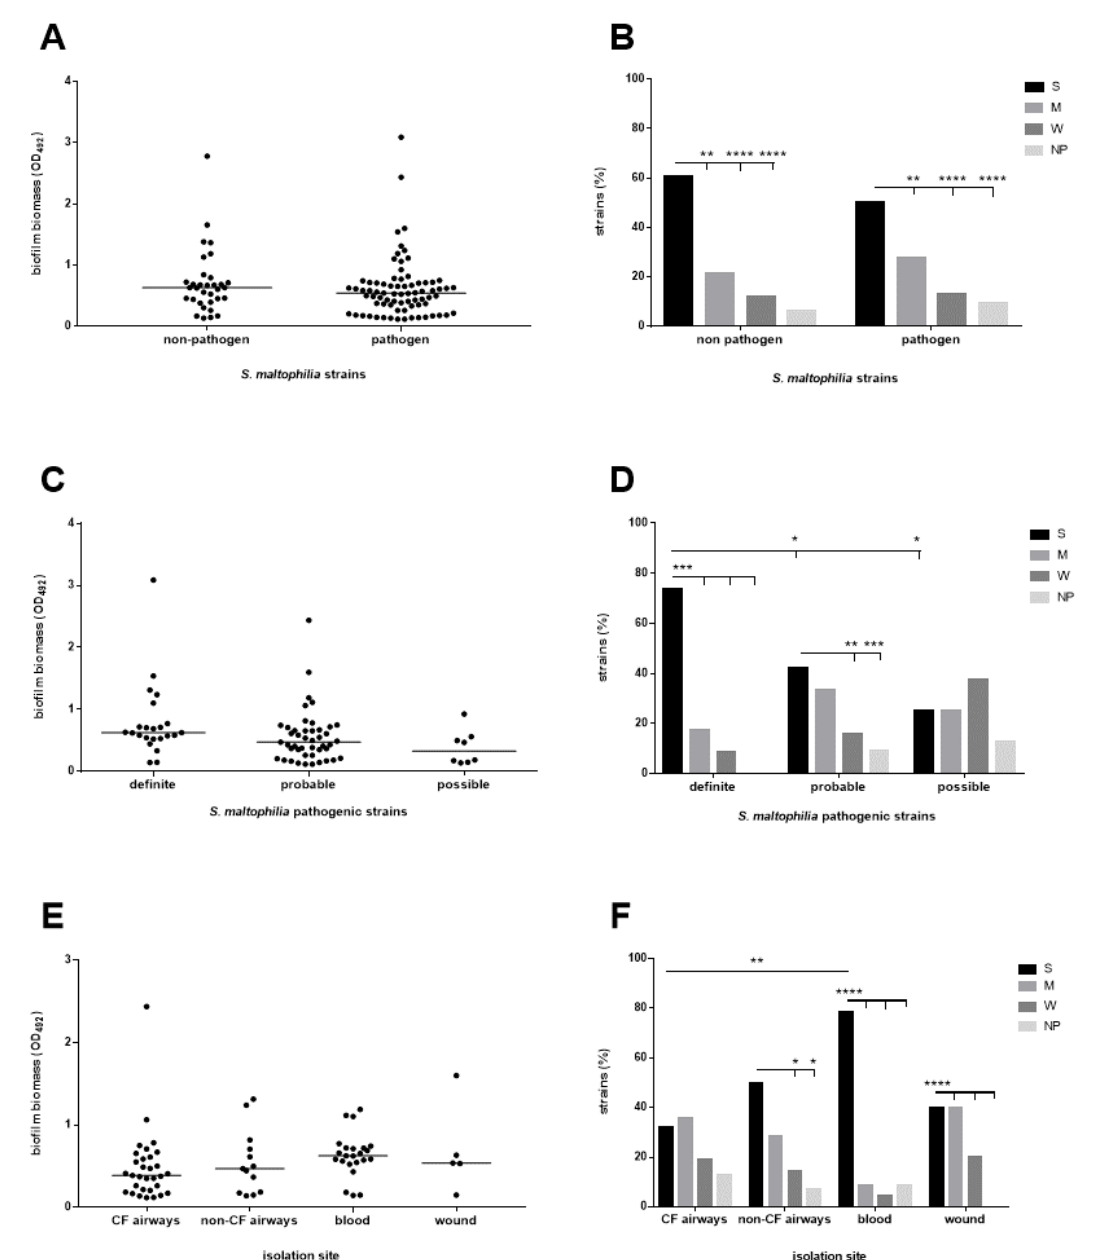
Figure 2. Biofilm formation by S. maltophilia strains and microbiological traits. Biofilm biomass formation was evaluated using MTP assay. Each strain was classified as: (i) strong—(S), moderate—(M), weak—(W) or non-producer (NP) based on the biofilm biomass value and according to Stepanovi´c et al. [24]; (ii) pathogen (definite, probable, possible) or non-pathogen according to the CDC guidelines [22]. ( A , C , E ) Each dot shows the mean biofilm biomass (OD492 value; n ≥ 6), with the horizontal line showing the median value of each distribution. No statistically significant differences were found using a Kruskal-Wallis test followed by a Dunn’s multiple comparison post-test. ( B , D , F ) the percentage of strains belonging to each group. * p < 0.05, ** p < 0.01, *** p < 0.001, and **** p < 0.0001, Fisher’s exact test.